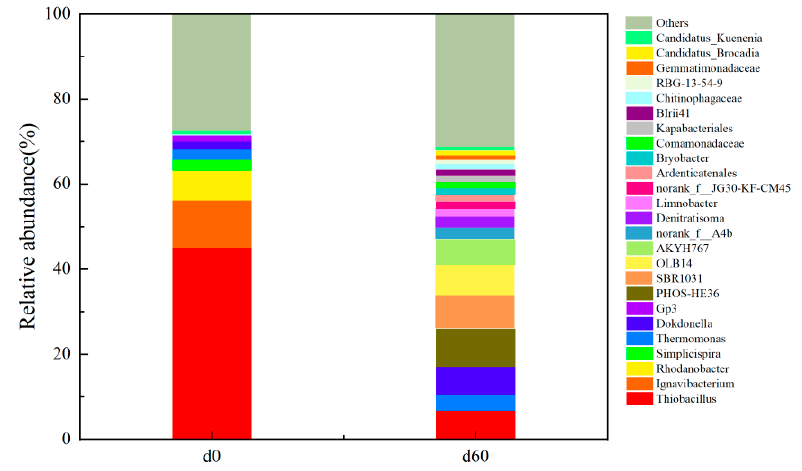
Figure 5. Comparison of the composition of the microbial communities.